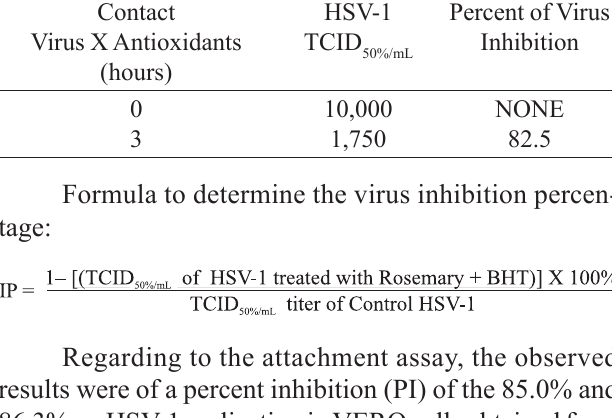
TABLE II – Viral inhibition of the natural antioxidant from rosemary ( Rosmarinus officinalis, L .) 300 ppm and synthetic